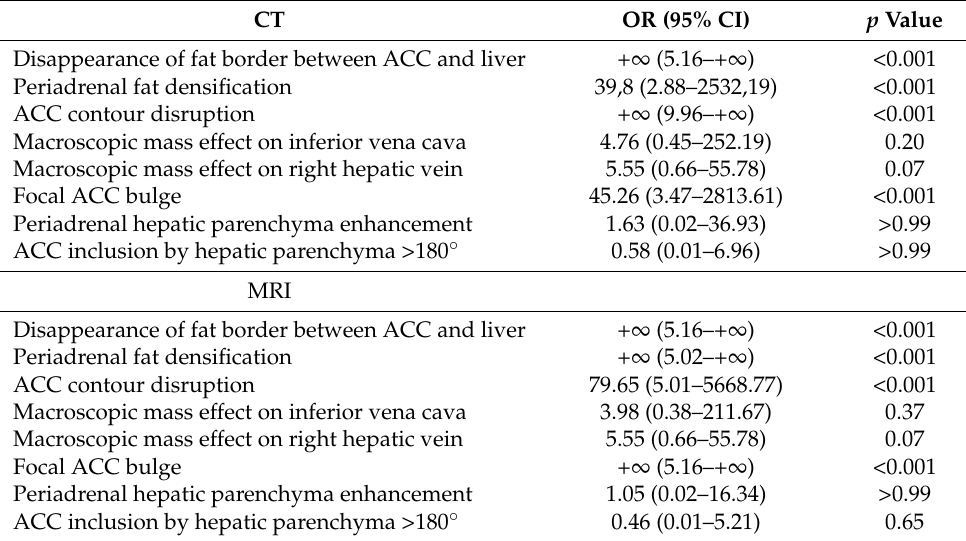
Table 6. Evaluation of the association between independent imaging findings and the actual status of DLI using logistic regression analysis in 29 patients with operated right